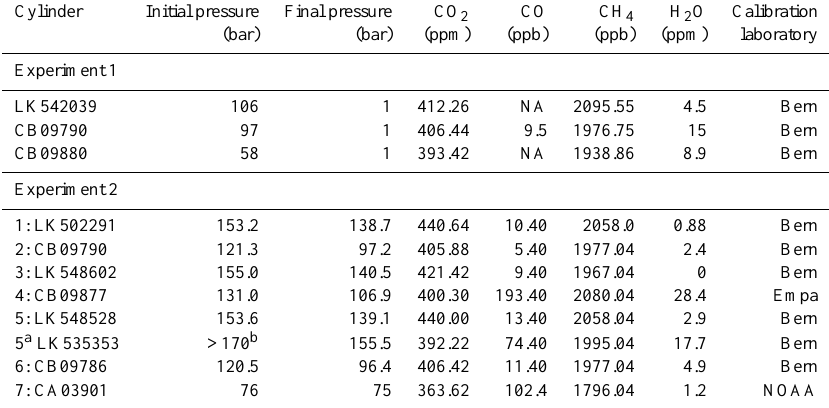
Table 1. Cylinders used for the two experiments with their identification and trace gas mole fractions. Note that the absolute values of both CO and H 2 O are of lower quality due to values close to the lower end of the measurement range. Note that no pretreatment of cylinders has been applied by us, i.e. no steam cleaning, surface conditioning, or finishing, except that applied by the supplier (see main text). Values displayed in figures are non-calibrated values.